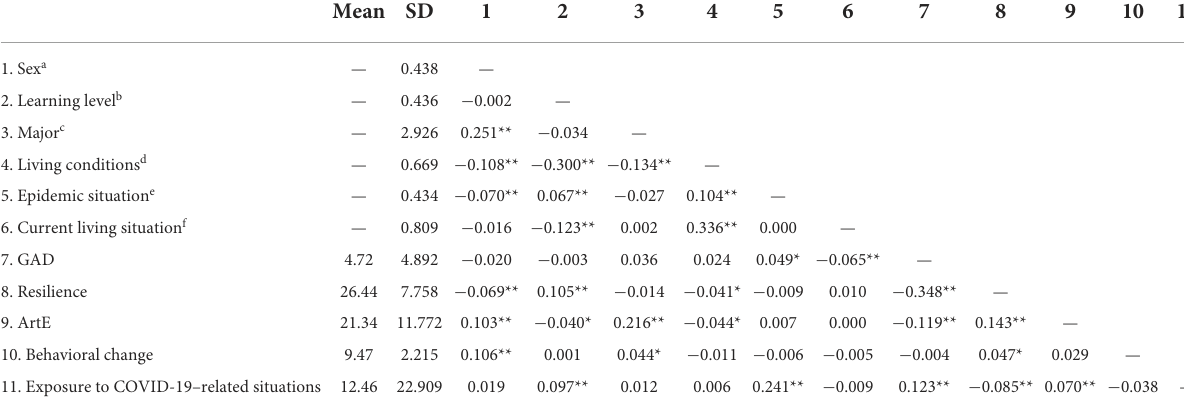
TABLE 2 Demographics and correlations table for the study